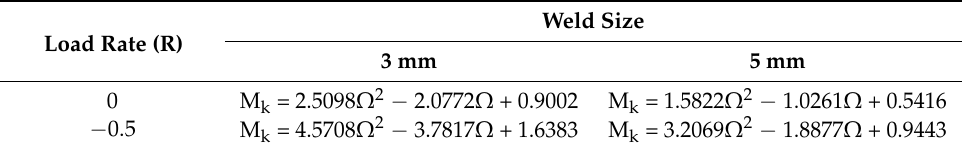
Table 8. Adjusted expressions for the modified weld magnification factor M k for the condition of post weld cooling in calm air.